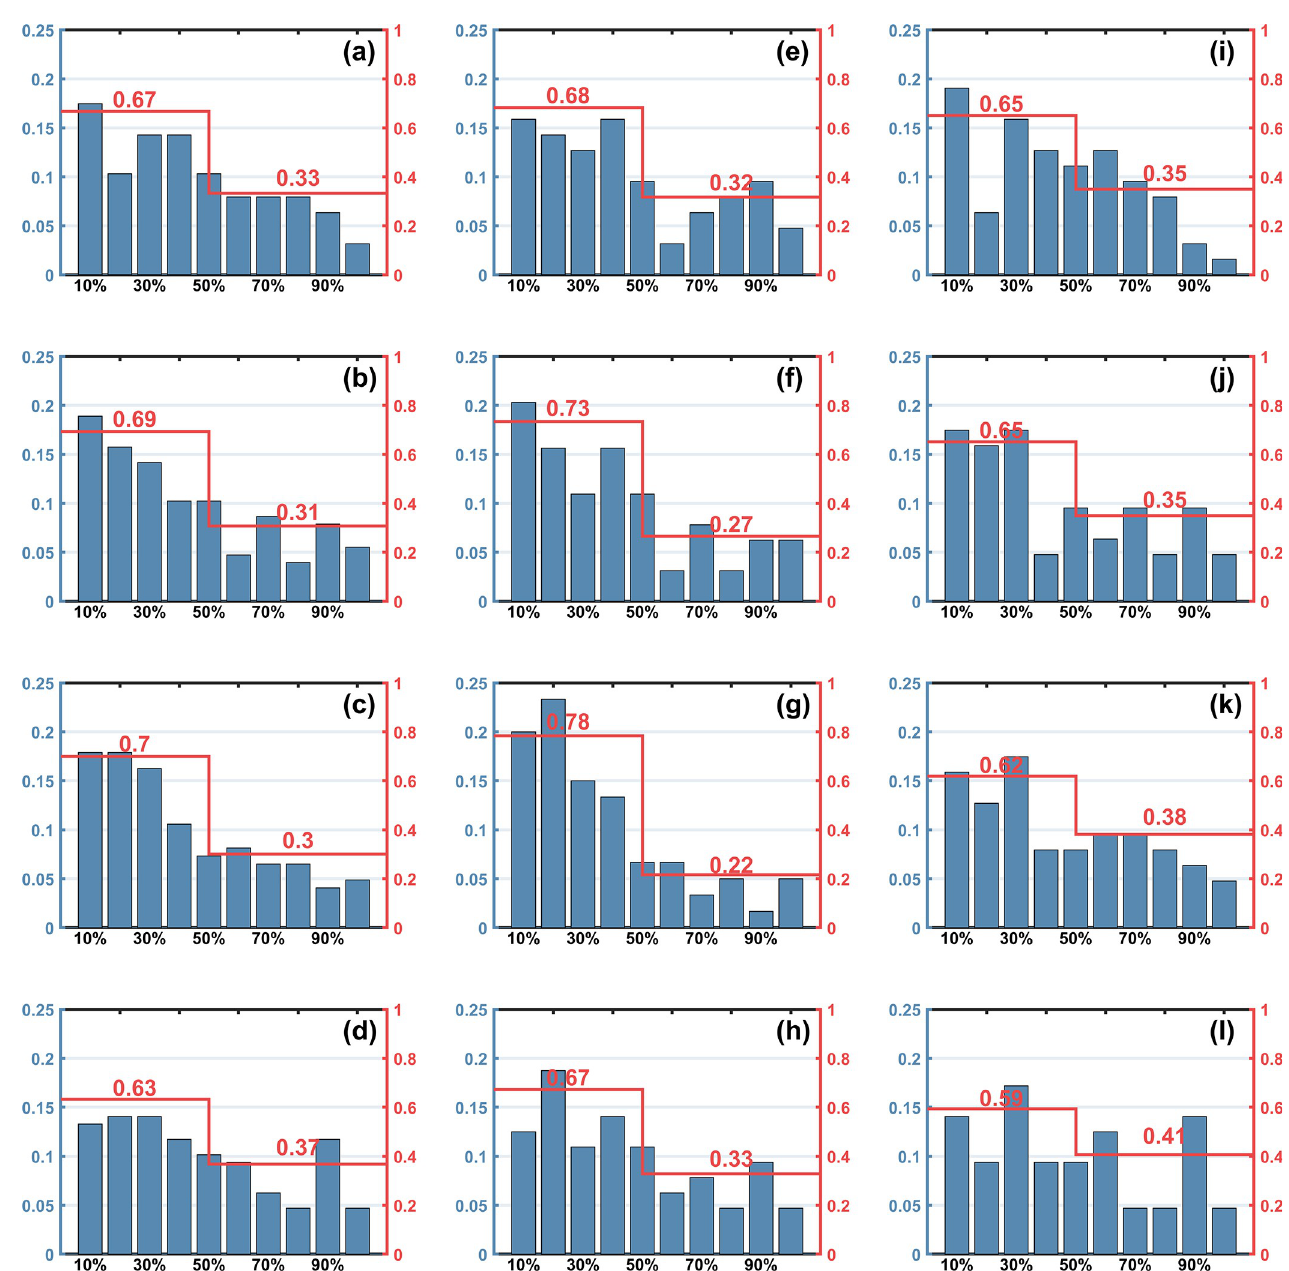
Fig 2. Percentage of athletes of different PFT rankings who entering the quarterfinals. The percentage of all athletes (a-d), female athletes (e-h) and male athletes (i-l) ranked by PFT among the top 8 athletes in the four competitions, each row in this figure is the results of one competition. The red ladders and numbers indicate the percentage of athletes in the top 50% and bottom 50% of the PFT who entering the quarterfinals.